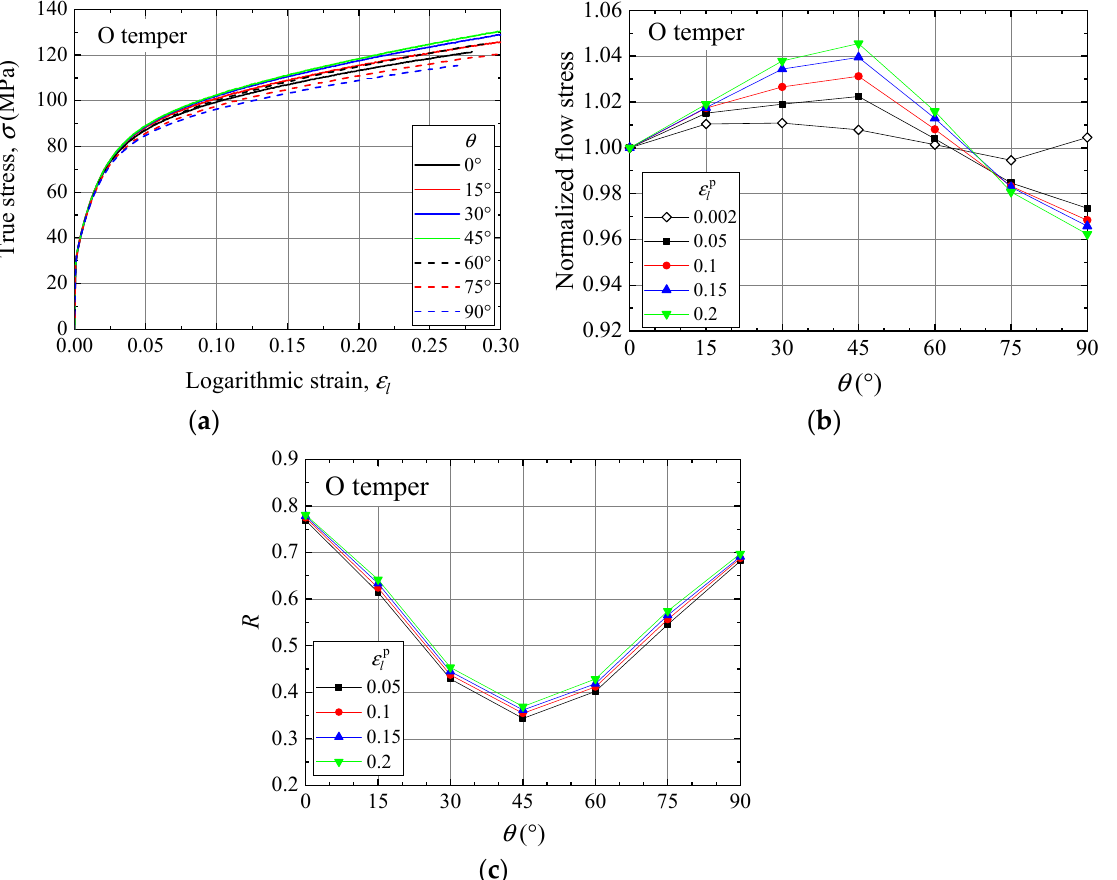
Figure 3. Results of uniaxial tension for O temper sheet. ( a ) True stress–logarithmic strain curve; ( b ) Normalized flow stress; and ( c ) R value.